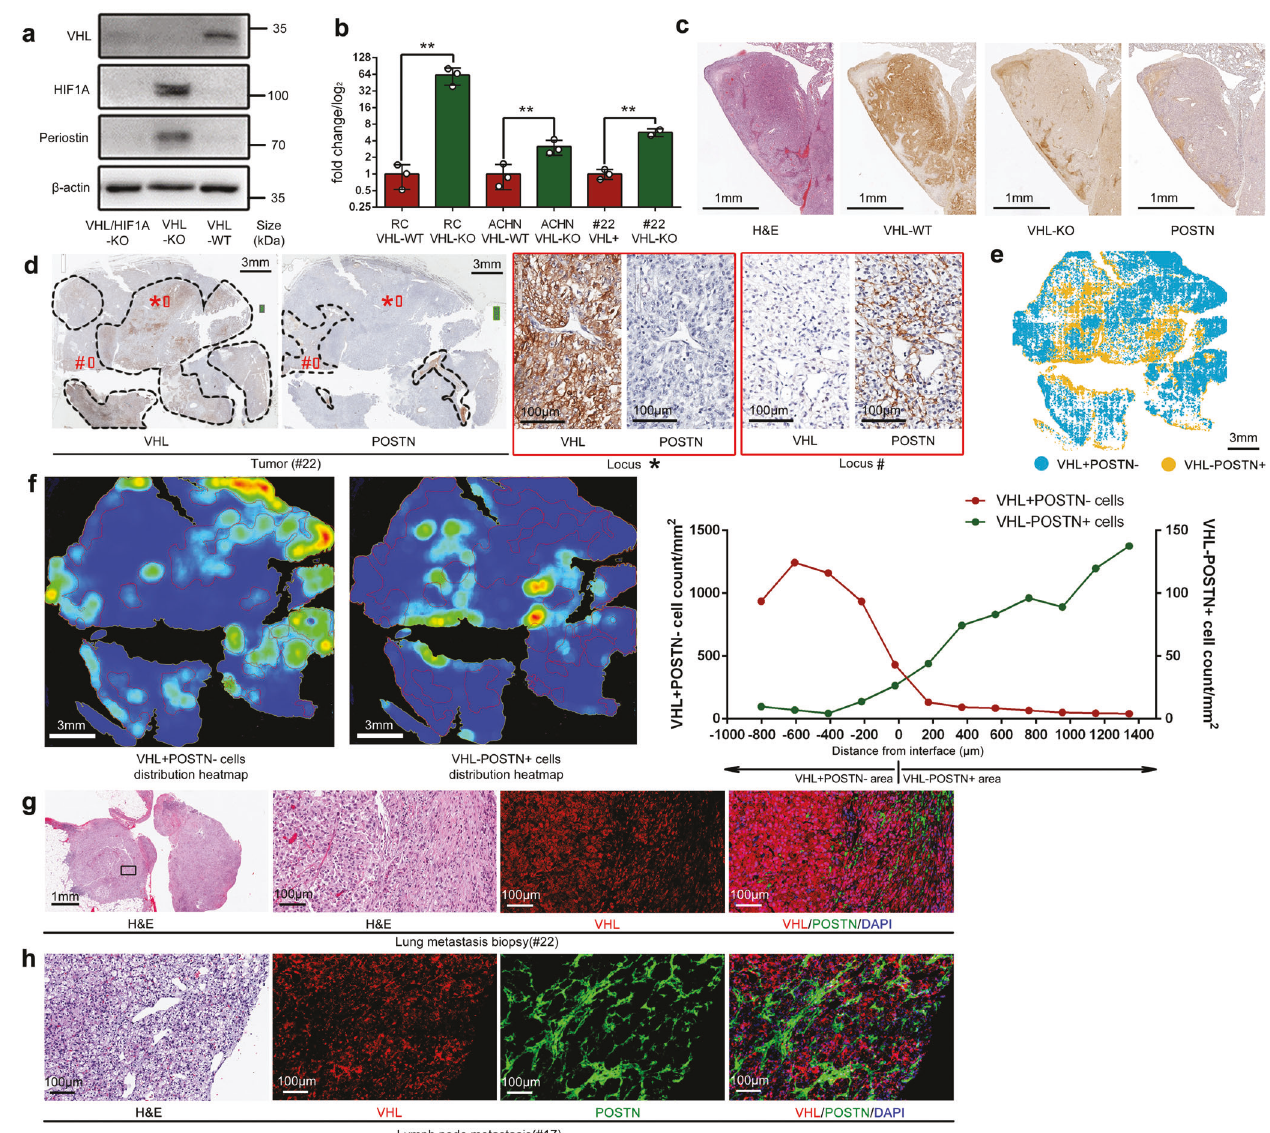
Fig. 4 POSTN is overexpressed in VHL-KO or VHL − cells in tumors. a Western blot assessing the expression of VHL, HIF1A and POSTN protein in RENCA VHL-WT, VHL-KO and VHL/HIF1A double knockout cells. b qRT-PCR of POSTN RNA in RENCA, ACHN and the patient-derived primary cells from case #22 and the VHL-deleted derivative (VHL-KO) of each. Student t-test was used in the comparison with triplicate repeats and presented with mean ± SD. c Serial sections from a large, lung metastatic lesion resulting from implantation of a 1:1 mixture of VHL-WT and VHL-KO cells were stained with H&E and IHC against HA tag (VHL-WT cells), fl ag tag (VHL-KO cells), and anti-POSTN. Scale bar: 1 mm. d Serial sections of the primary tumor tissue from case #22 were stained for VHL and POSTN. Dotted encircled areas are VHL-positive cell aggregated areas (left) and POSTN positive aggregated areas (right). Higher magni fi cation of the boxed areas ( a ) and ( b ) are shown on the right. Scale bar for low magni fi cation fi eld: 3 mm; for high magni fi cation fi eld: 100 μ m. e Multiplex IF stain, analyzed by HALO software, showing the cellular distribution of VHL + POSTN − and VHL − POSTN + cells in case #22 primary tumor. Scale bar: 3 mm. f HALO analysis in ( e ) was used to generate heatmap of VHL + POSTN − and VHL − POSTN + cells. Warmer colors (orange) identify areas of denser cells, and cooler colors (dark blue) signify areas with sparser cells. The rightmost plot scored the VHL + POSTN − and VHL − POSTN + cells in each evenly divided area with respect to the interface border of the VHL + POSTN − area. It shows VHL + POSTN − cells (red curve, left y -axis) and VHL − POSTN + cells (green curve, right y -axis) do not co-localize in the same area. Scale bar: 3 mm. g The lung metastatic lesion of case #22 and ( h ) the retroperitoneal lymph node metastatic lesion of case #17 were stained by H&E and IF to detect VHL (red), POSTN (green), and nuclei, (DAPI, blue). Scale bar for the low magni fi cation fi eld: 1 mm; for the high magni fi cation fi eld: 100 μ m. (* p < 0.05, ** p < 3D migration assay through an extracellular matrix reaf fi rmed the paracrine crosstalk. First, we generated two double-gene knockout results of the 2D assay (Supplementary Fig. 4g and Supplementary lines to abrogate POSTN expression: VHL and HIF1 α (RC-VHL/ Movie S2a – d). Conditioned medium from VHL-KO cells also HIF1A-KO, Fig. 4a) or VHL and POSTN (RC-VHL/POSTN-KO, Fig. 5f). enhanced the motility of VHL-WT cells (Fig. 5e and Supplementary Both of these double knockout lines exhibited signi fi cantly Movie S3), supporting soluble factor(s) produced by VHL-KO cells decreased augmentation of VHL-WT cells ’ motility compared to promoting cellular motility.